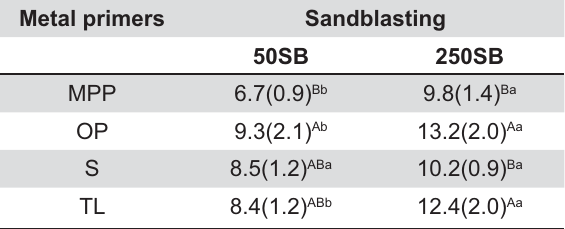
Table 1- Shear bond strength (MPa) mean values (±standard deviations) of resin composite to sandblasted cpTi surfaces with metal primers. Means followed by the same capital letters in a column and lower case on the